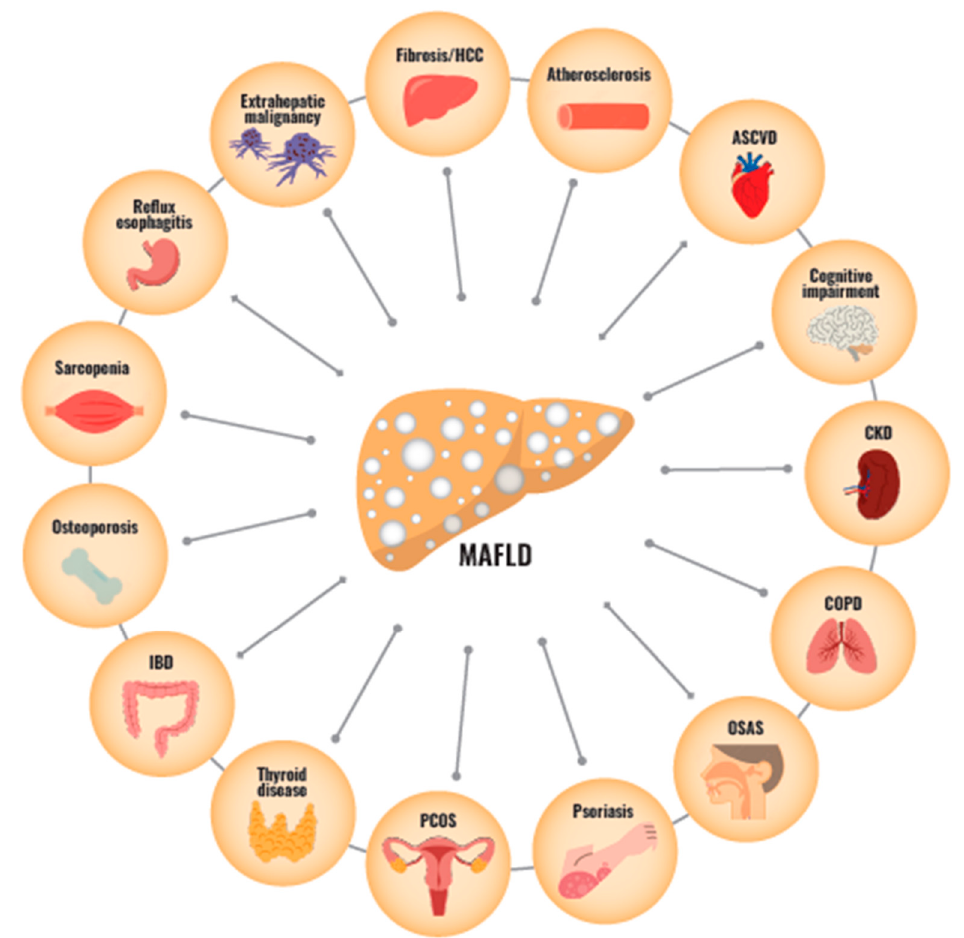
Figure 4. The relationships between MAFLD and multiorgan disease. Abbreviations: MAFLD, metabolic abnormality-associated fatty liver disease; ASCVD, atherosclerotic cardiovascular disease; CKD, chronic kidney disease; COPD, chronic obstructive pulmonary disease; OSAS, obstructive sleep apnea syndrome; PCOS, polycystic ovary syndrome; IBD, inflammatory bowel disease; HCC, hepatocellular carcinoma.